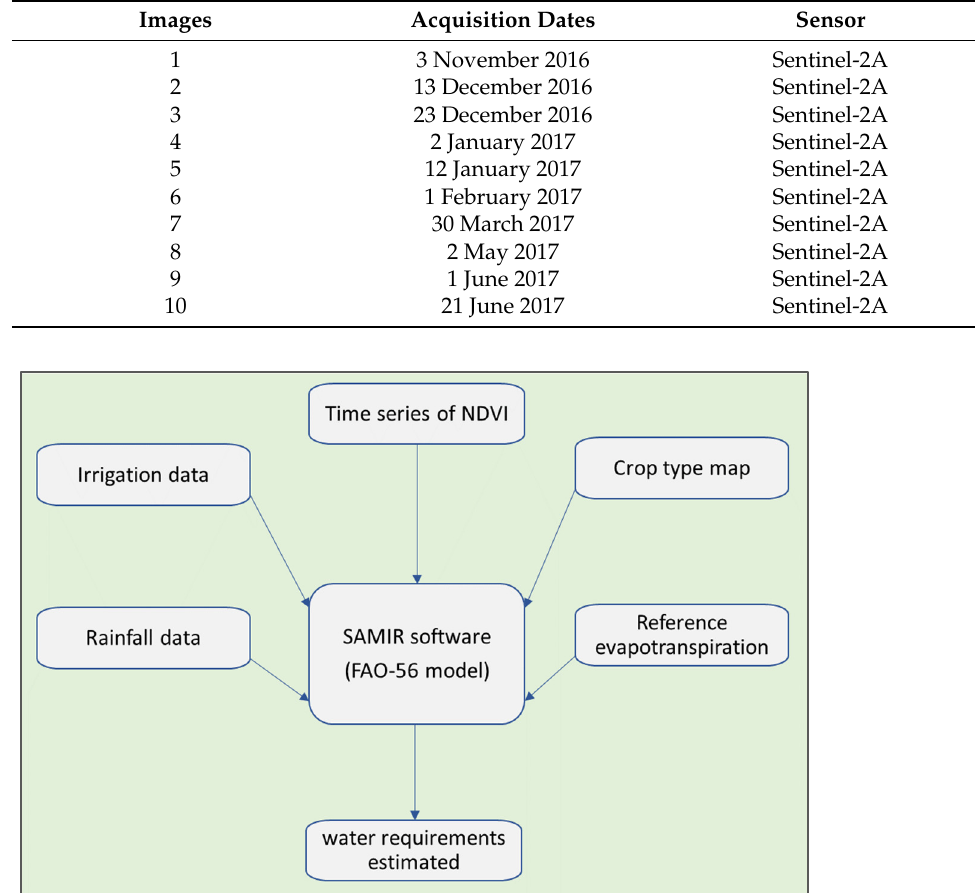
Figure 3. Flowchart of the methodology used. Table 1. Sentinel-2A image acquisition dates.